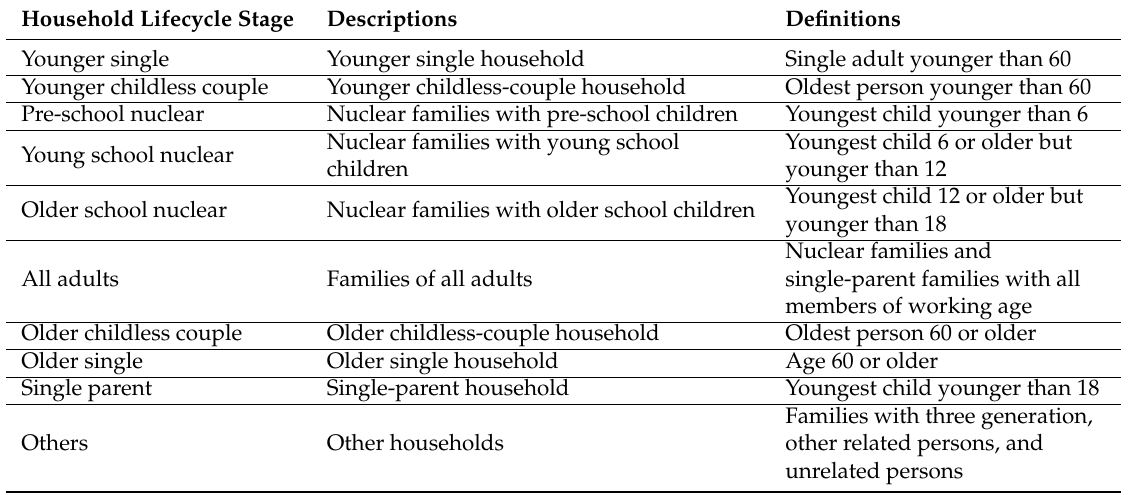
Table 1. Descriptions and Definitions of lifecycle